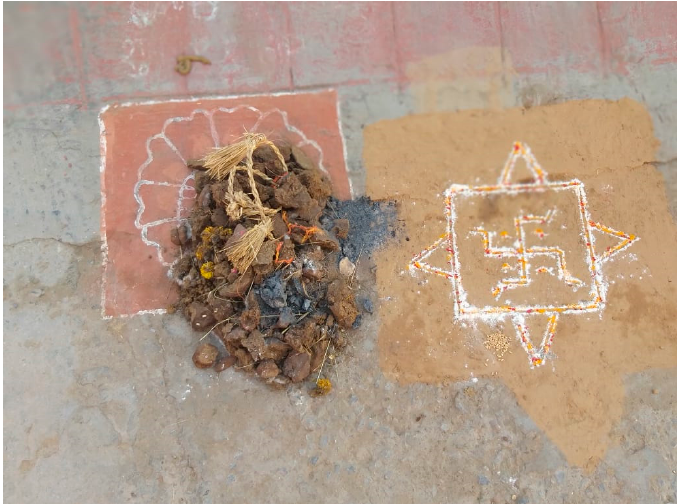
Figure 8. Dried-up Govardhan, completed with a Swastika: a good luck design made of flour, turmeric and sindoor (vermilion red powder) on the lunar day of ekadeshi, Havala 2018 (picture by Francine Jain).